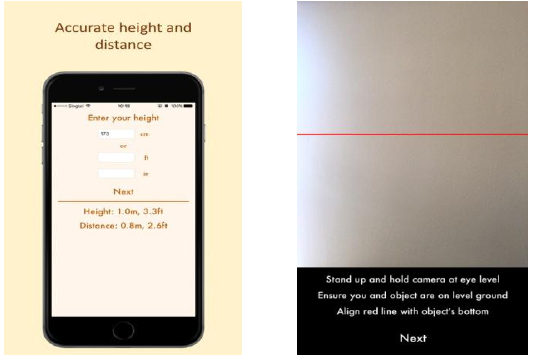
Fig. 2. Object Height app’s user interface